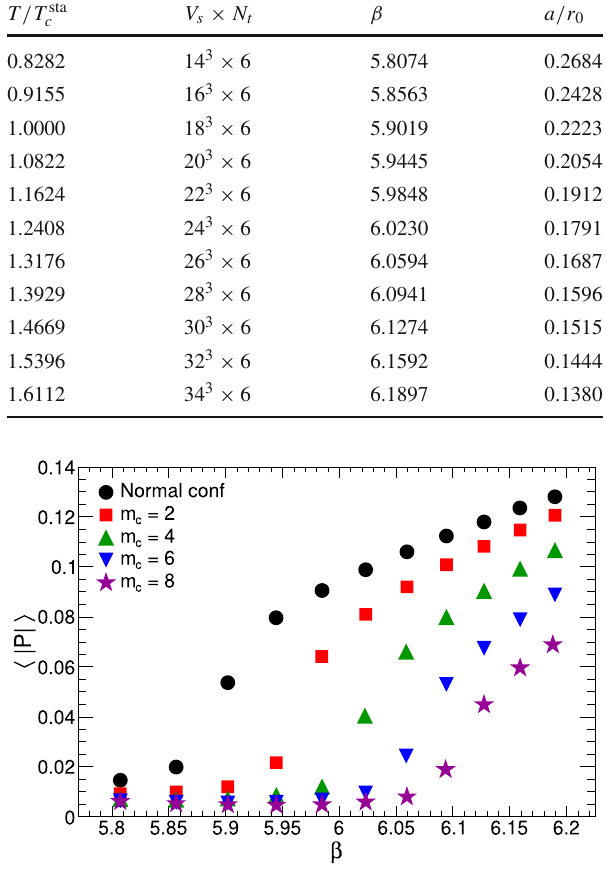
Fig. 3 The phase transitions varying with increasing the magnetic charge